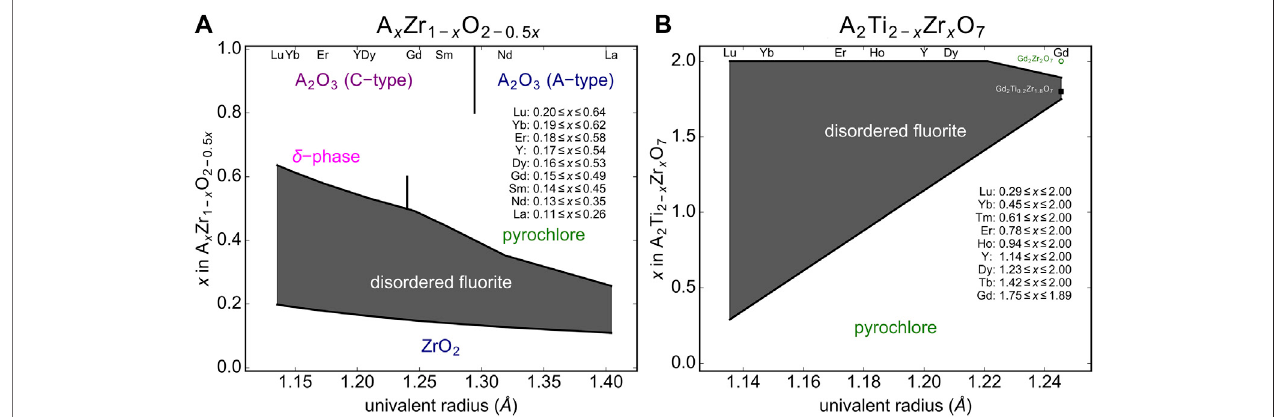
FIGURE7| Predicteddisordered fl uoritestability fi eld(grayshadedregion)for (A) stabilizedzirconiacompounds(A x Zr 1- x O 2-0.5 x )and (B) A 2 Ti 2- x Zr x O 7 solid-solution series with A representing the variable cation. The phase boundaries are established by the compositional parameter x and the univalent radius limits based on relations given in Eq. 4 . Neighboring phases are shown for zirconia (ZrO 2 ), sesquioxides (cubic “ C-type ” and trigonal “ A-type ” A 2 O 3 ), δ -phases (A 4 Zr 3 O 12 ), and pyrochlores (A 2 B 2 O 7